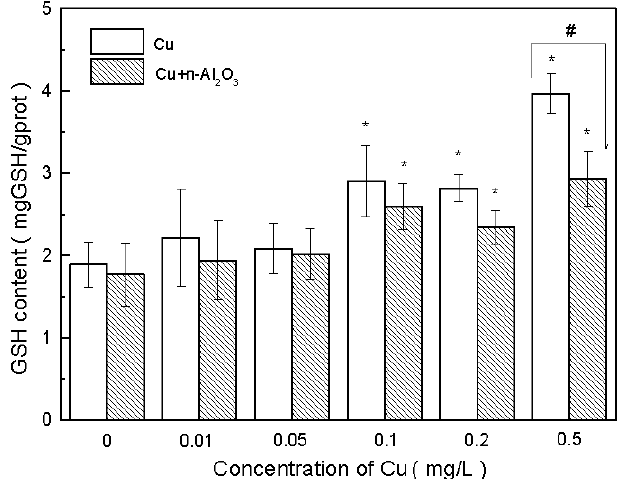
Figure 4. Reduced glutathione (GSH) concentrations in S. obliquus exposed to copper and copper/nano-Al 2 O 3 systems at different concentrations of copper after 72 h. Data are mean ± SD ( n = 3). Asterisks indicate the significance of differences ( p < 0.05) between the control and the exposed treatments. Pound signs indicate the significance of differences ( p < 0.05) between the copper system and the copper/nano-Al 2 O 3 system at the same concentration of copper.